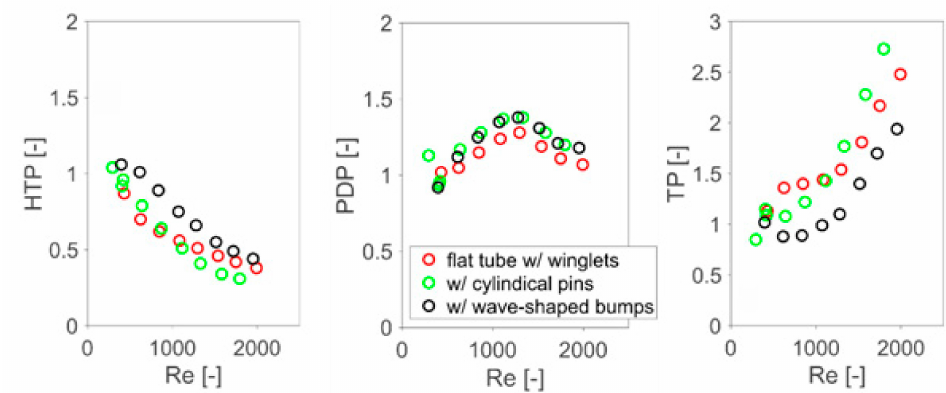
Figure 18. Heat transfer performance (HTP) and pressure drop performance (PDP) as well as total performance (TP) criterion for the tubes investigated in this contribution for Pr =